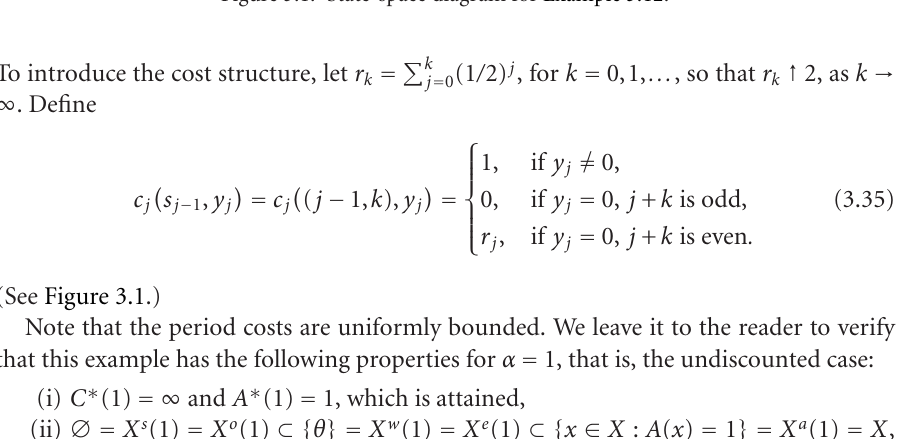
Figure 3.1. State-space diagram for Example